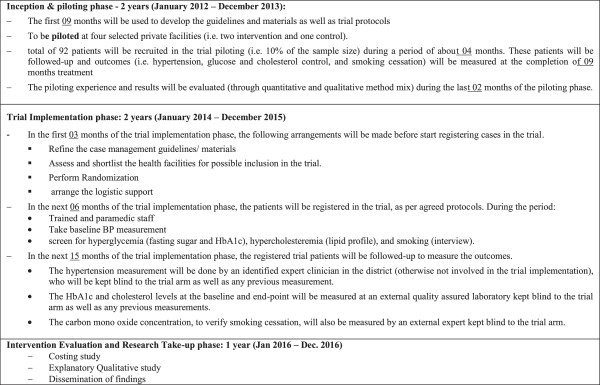
Phases of the trial.